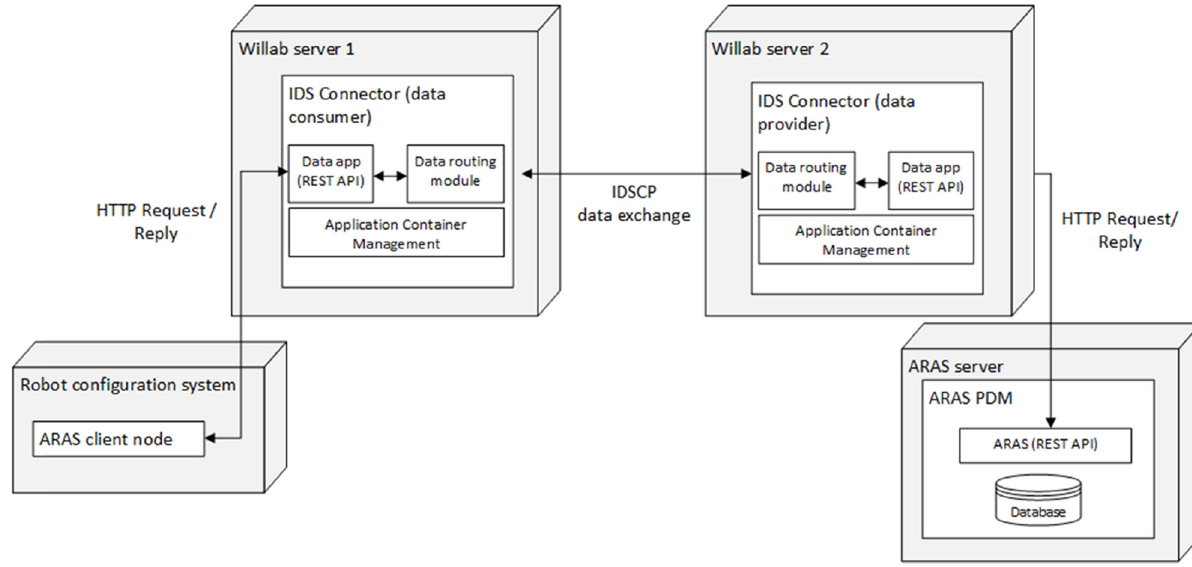
Figure 11: System architecture: integration of the shop fl oor devices and PLM systems of di ff erent parties via